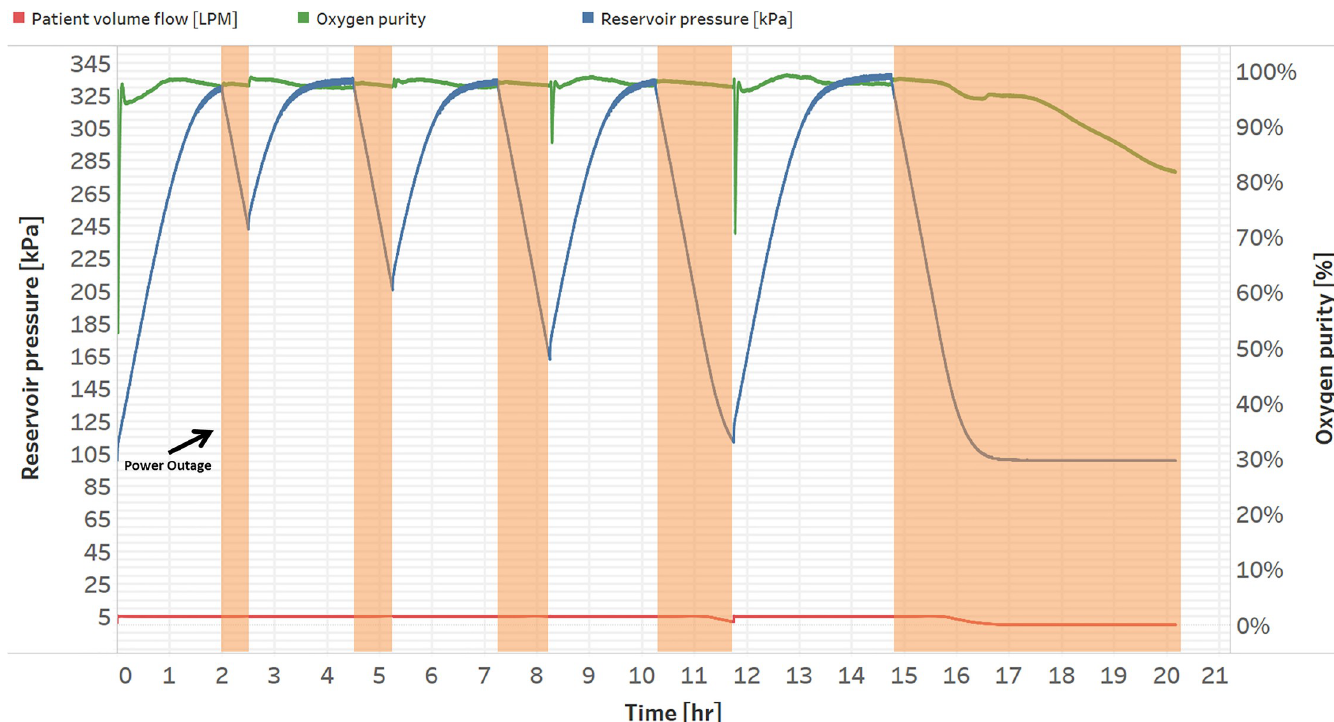
Fig 2. Laboratory test of the low-pressure reservoir system. Power outages were imposed on the system with intervals of 15 to 90 minutes in duration. The system flow rate was set at 5 liters per minute.